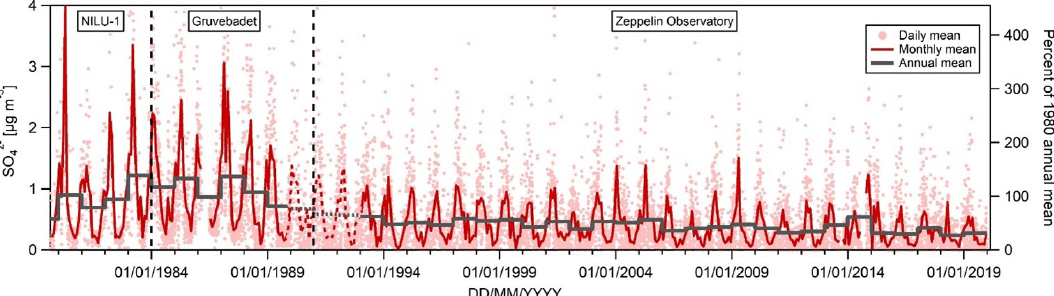
− ) concentrations at Ny-Ålesund (NILU-1), Gruvebadet, and the Zeppelin Observatory. Sulfate is sea salt corrected Figure 3. Sulfate (SO 2 4 except for 1990–1992 where total sulfate was measured, as also indicated by the dashed line. For reference, the right axis shows levels relative to the 1980 annual mean of 0.92µgm − 3 . Daily and annual means calculated only where data coverage is ≥ 75% of the total day or year,